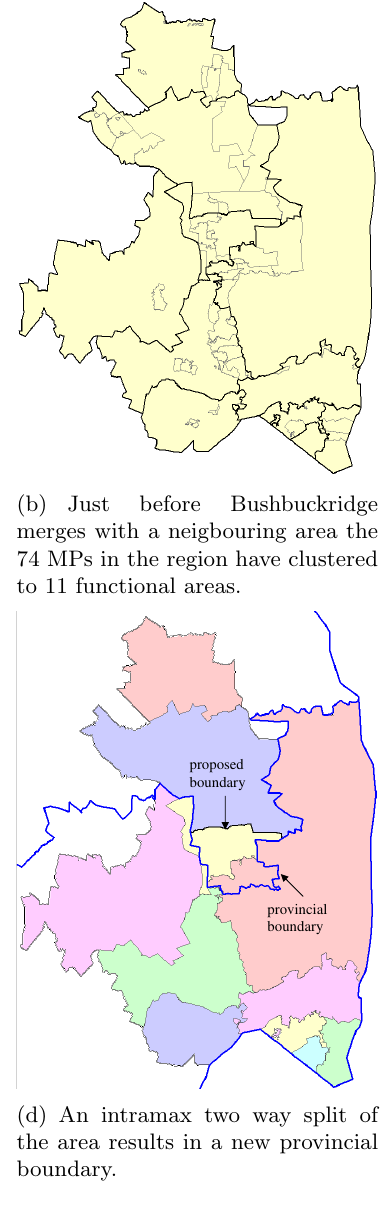
Figure 10: In-depth analysis of Bushbuckridge as example of a disputed